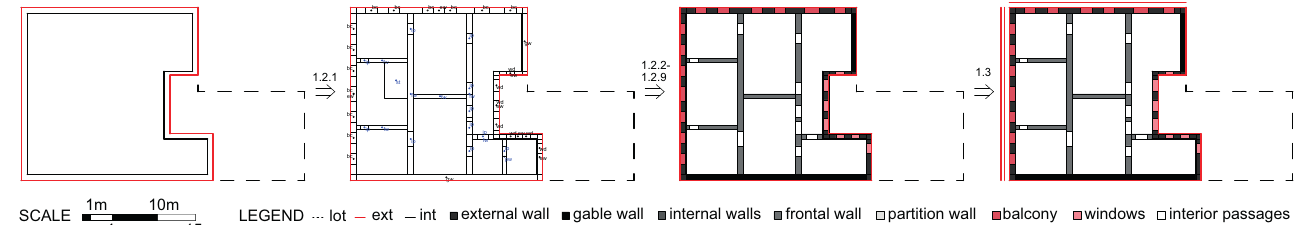
Figure 7. Derivation process considering steps for stage 1 for the case study building